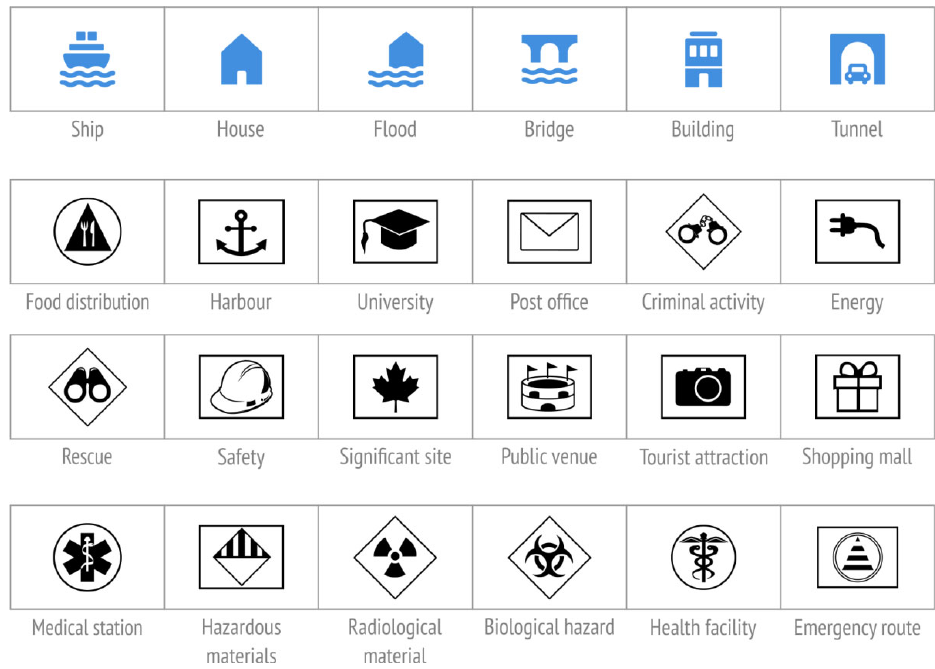
Figure 5. Examples of different representation strategies in the analysed symbol sets: visual similarity (top), semantic association (middle) and arbitrary convention (bottom). The representation is semantically closest on the top symbols, and semantically farthest on the bottom symbols.